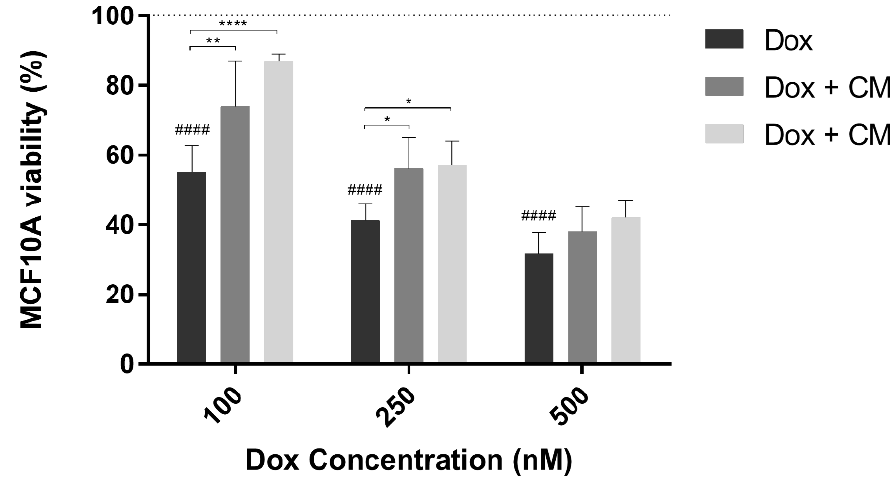
Figure 5. Combinatory exposure of MCF10A cells to MSC CM increased the viability of non- tumor breast cells exposed to Dox. The MCF10A cells were incubated with 0–500 nM of Dox alone and in combination with both conditioned media, CM2D or CM3D, and evaluated by MTS reduction assay. Cell viability is expressed in percentage (mean ± SD, n = 3–6) to non-treated MCF10A (control). Grid line represents 100% cell viability (control). Statistical significance is expressed relative to Dox as * p < 0.05, ** p < 0.01, **** p < 0.0001 and to control of non-treated cells, i.e., 100% viability as #### p < 0.0001. CM2D, conditioned medium derived from 2D cultures; CM3D, conditioned medium derived from 3D cultures; Dox, doxorubicin.